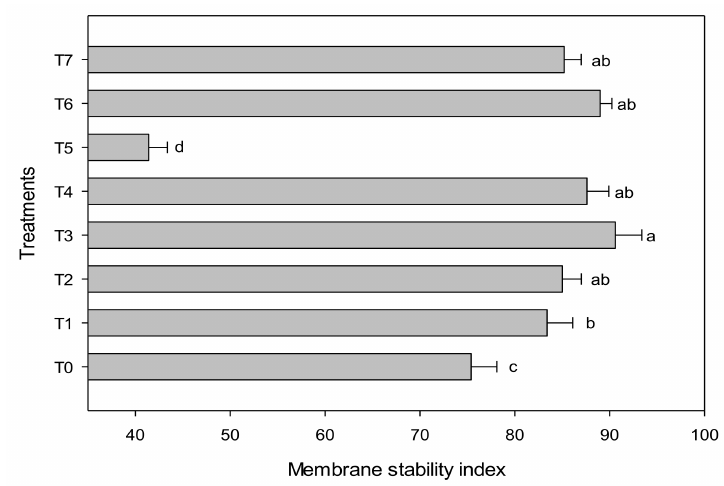
Figure 4. Effect of SWE on mitigating salt stress effects on the membrane stability index of tomato leaves. Mean ( ± SEM) of 5 replicates. Within each time point, the same letter indicates no signif- icant difference ( p ≤ 0.05) in a Tukey’s test. (T0—Control, T1—NC, T2—NC + S150mM, T3—PC, T4—PC + S150 mM, T5—S150 mM, T6—SWE 80%, T7—T5 +